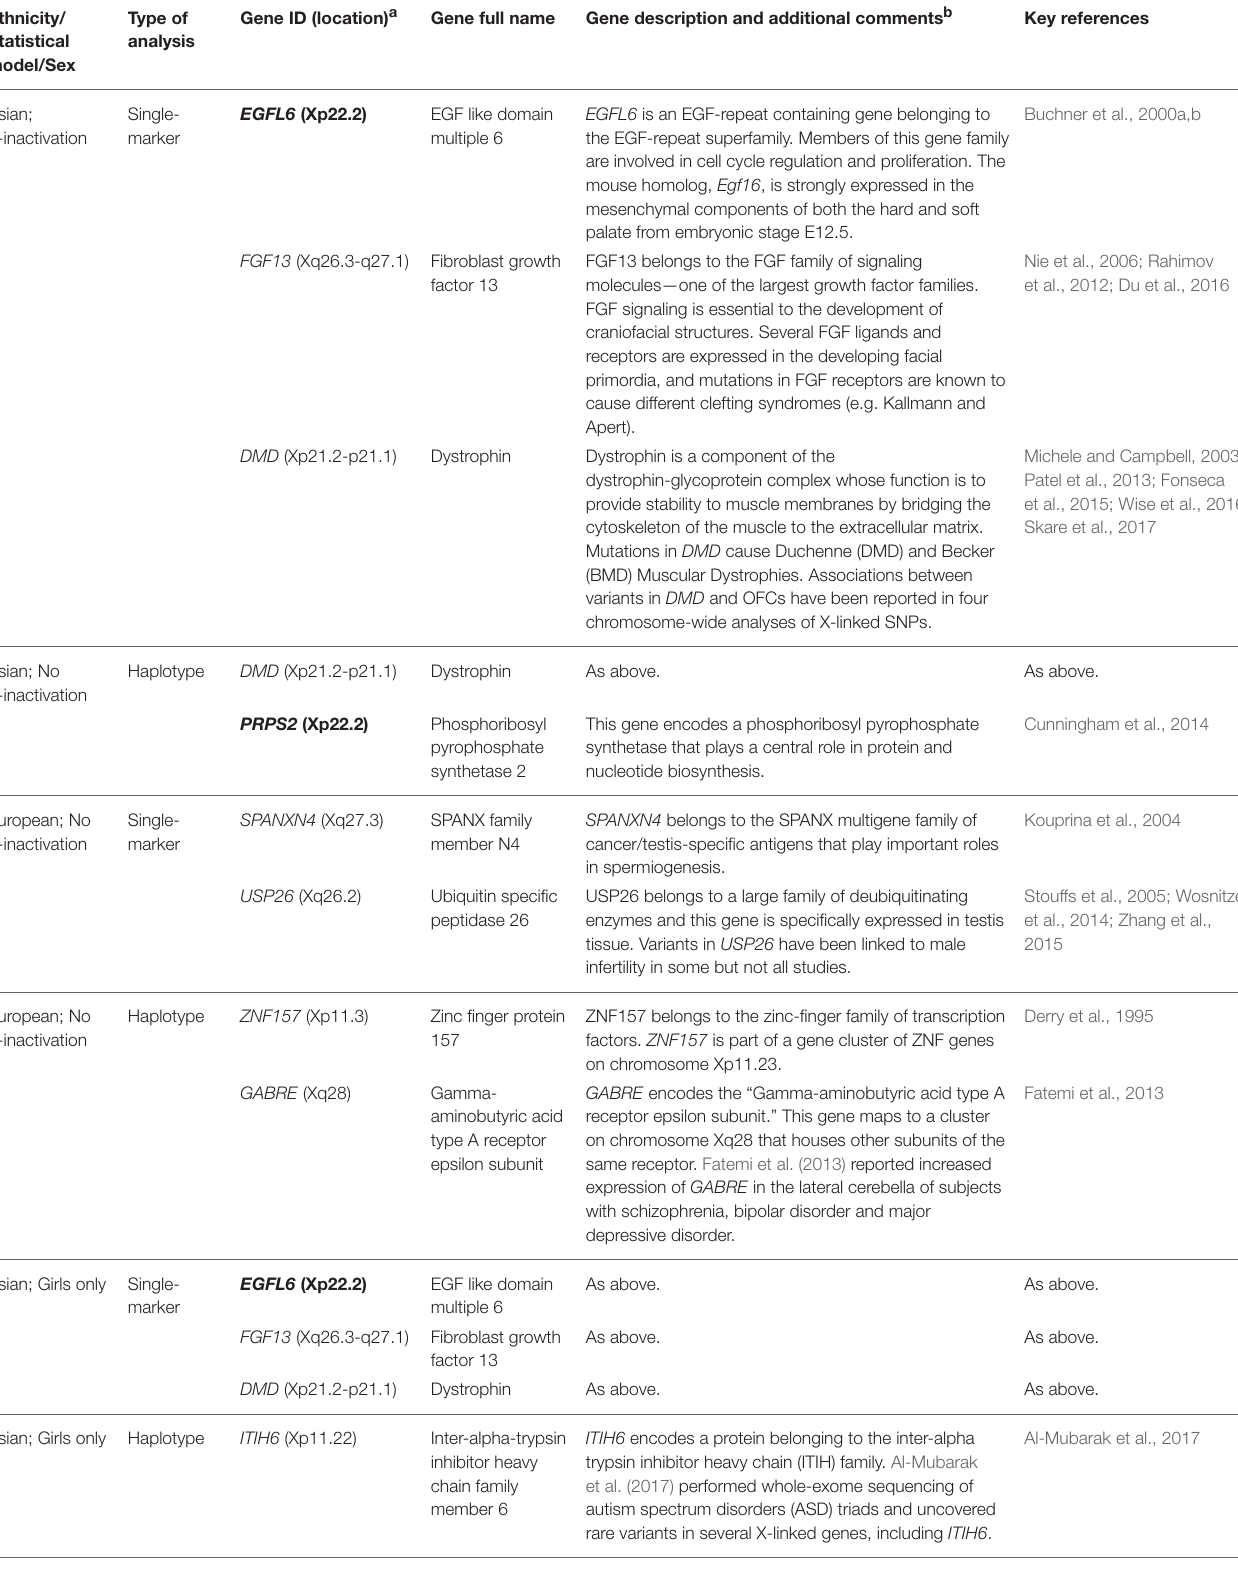
TABLE 3 | Synopsis of the genes in which associations were identified in this